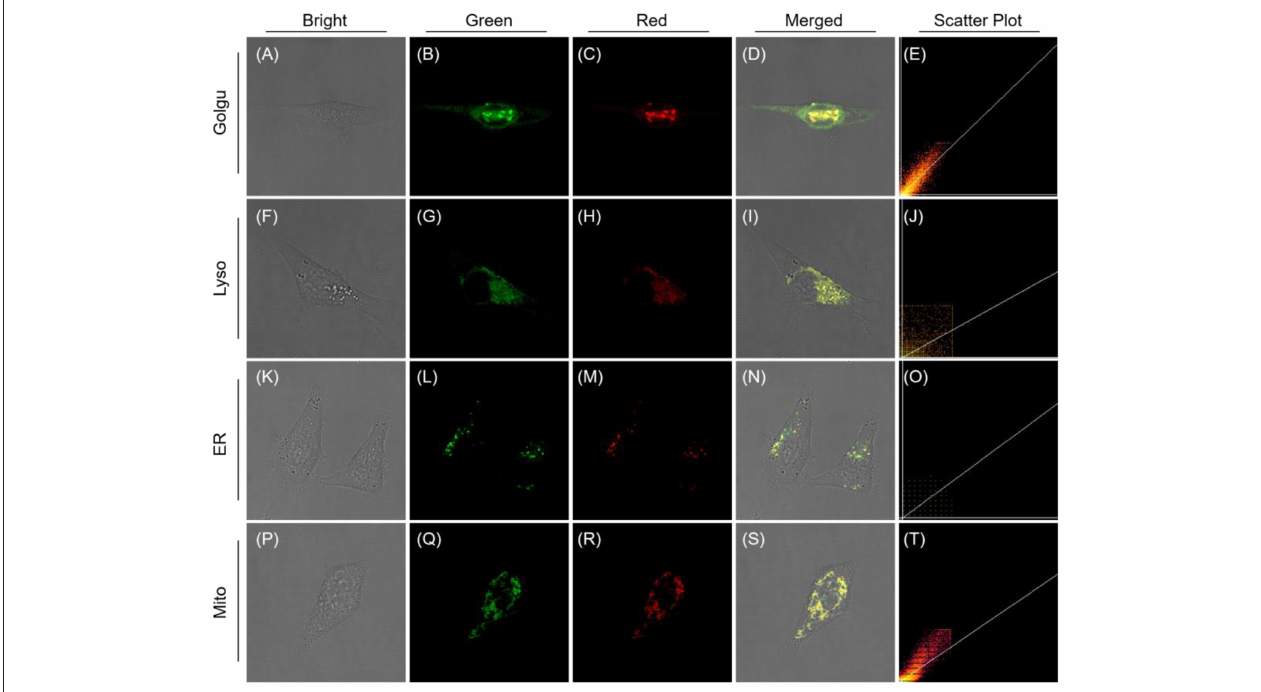
FIGURE 4 | CLSM images for intracellular localization of QM-HBT- β gal in SKOV-3 cells. Cells were incubated with QM-HBT– β gal (10 µ M) for 2 h and then co-stained with 1 µ M Golgi-Tracker Green (BODIPY FL C5-Ceramide) (A–E) , 100 nM Lyso-Tracker Red DND-99 (F–J) , 1 µ M ER-Tracker Red (BODIPY TR Glibenclamide) (K–O) , and 200 nM Mito-Tracker Red for 30 min (P–T) , respectively. The green channel at 510–530 nm for Golgi-Tracker Green (B) , λ ex = 505 nm; 610–630 nm for ER-Tracker Red (L) , 590–610 nm for Lyso-Tracker Red DND-99 (G) and Mito-Tracker Red (Q) , λ ex = 561nm. The red channel at 650–700nm, λ ex = 460nm.